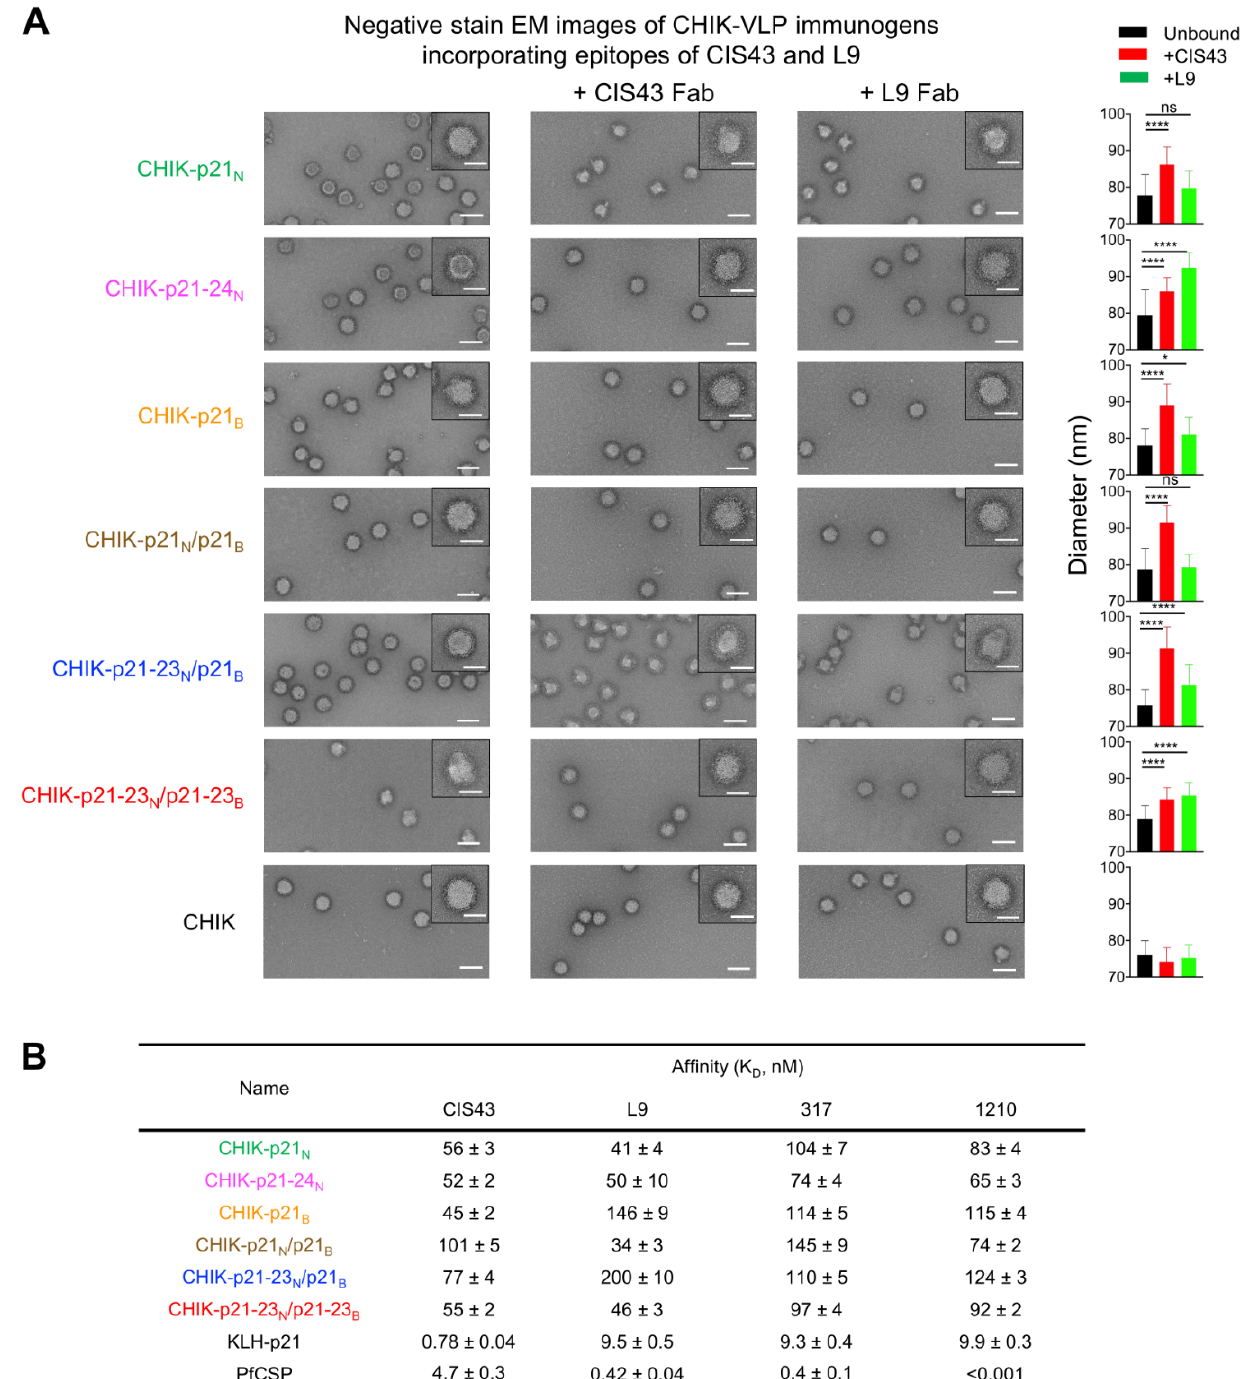
Figure 2. Negative-stain EM and antigenicity of junctional peptide-CHIK-VLP immunogens. ( A ) (Left) Images from negative-stain EM of PfCSP peptide-CHIK-VLP immunogens incorporating CIS43 and L9 epitopes, with and without CIS43 or L9 Fabs. CHIK-VLP without PfCSP peptide (CHIK) was used as control. Scale bars: 100 nm in representative images; 50 nm in insets. (Right) Measured diameters of CHIK-VLP immunogens. Average values are shown in bars with error bar denoting standard deviation. Two-tailed t -tests were performed between unbound and CIS43 bound or L9 bound, respectively. *: p < 0.05. **** p < 0.0001. ns: p ≥ 0.05. ( B ) Affinity of CHIK-VLP immunogens towards antibodies CIS43, L9, 317, and 1210, respectively.